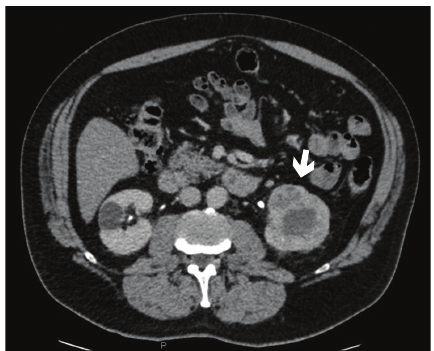
Figure 3: Accidental radiological finding of left renal mass